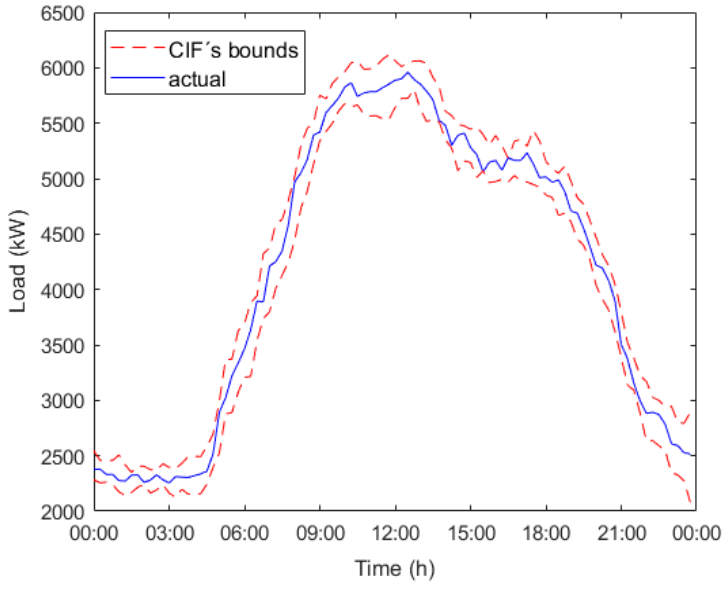
Figure 5. Predicted intervals and actual energy demand evolution for 8 February 2018 scenario ( α = 0.15, F = 1540 ) .